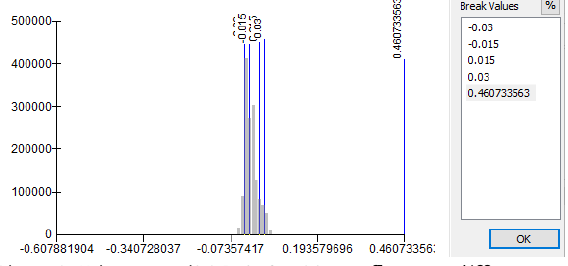
Figure 3. Histogram, iCOR & Sen2Cor reflectance differences. To evaluate the correlation between the outputs of both processors, the values are analysed with a scatterplot by displaying Sen2Cor values in the Y-axis and iCOR values in the X-axis. The standard deviations of the Sen2Cor processor are between 0.03-0.04 and for iCOR processor between 0.04-0.05. The correlation between reflectance values of two processors is